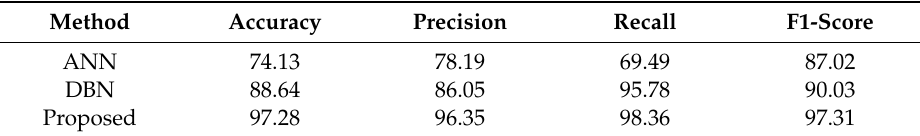
Table 8. Comparison results of other di ff erent methods